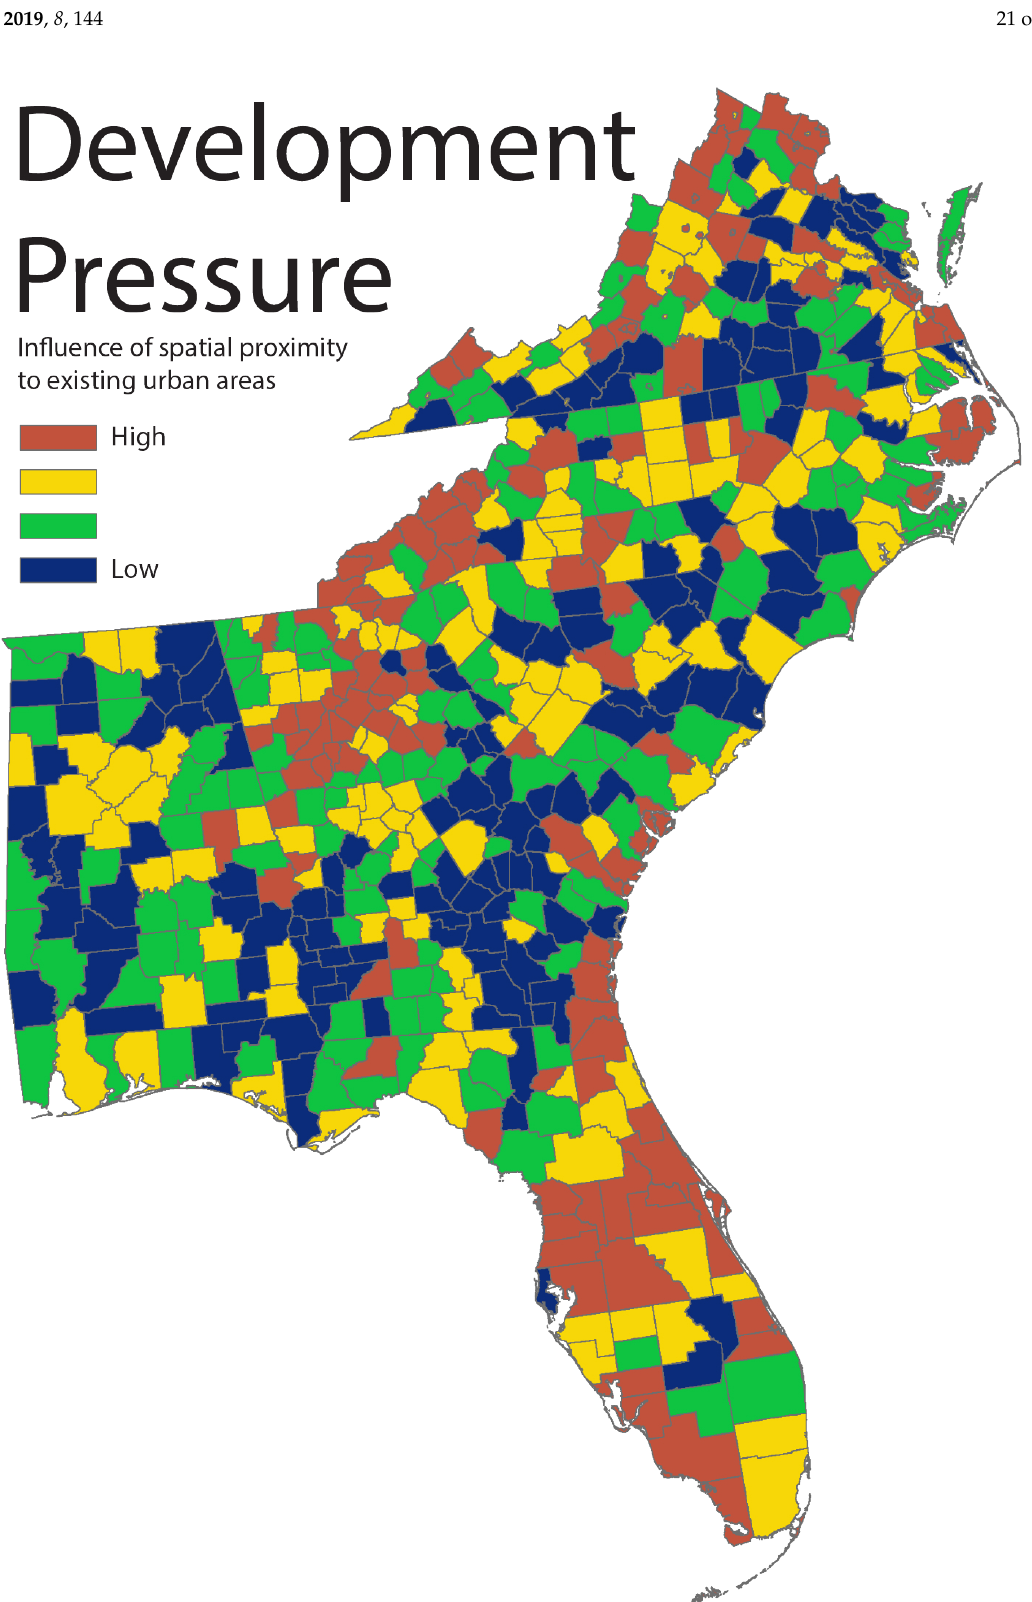
Figure A3. Map of mean development pressure based on the 2011 NLCD urban classes. Development pressure is an approximation of how existing urban development influences new growth. Urban developments near large urban areas are more likely to be in close proximity to existing developments. There is less development pressure in rural areas where proximity to existing developments influences growth